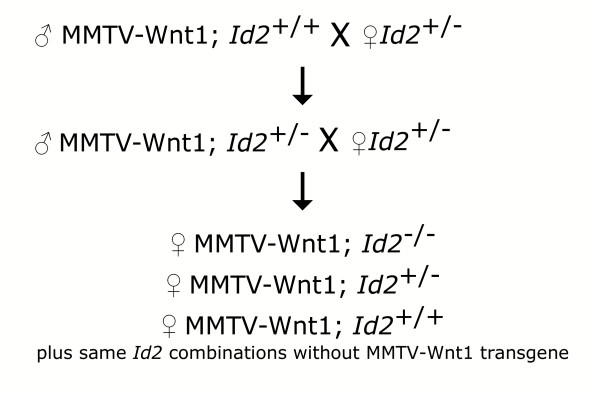
The Wnt1 transgene was crossed into an Id2 -/- background in order to produce cohorts of WT, Id2 +/-, and Id2 -/- females with and without the Wnt1 transgene. The scheme was designed so that mothers could feed their own young and so that all cohorts being compared would share a common background.